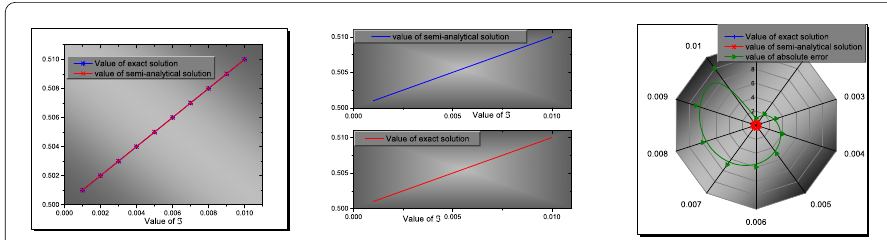
Figure 4 Semi-analytical wave solution of the Cahn–Allen equation by using Eq. (37) in combined, separated, and radar plots